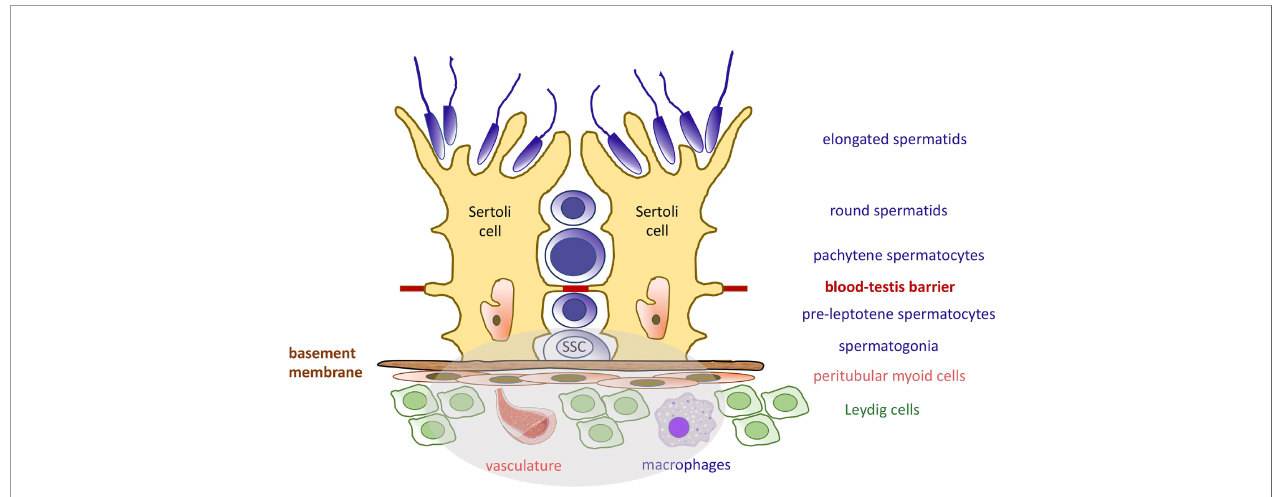
FIGURE 1 | Seminiferous Epithelium Organization and the Spermatogonial Stem Cell Niche. The seminiferous epithelium consists of germ cells (blue) and the somatic Sertoli cells (yellow). Sertoli cells produce many factors needed at various developmental steps during the spermatogenic process. The blood-testis barrier separates diploid germ cells from more mature cells and provide an immuno-privileged microenvironment for the completion of meiosis. Like Sertoli cells, the spermatogonial stem cells (SSCs) are attached to the basement membrane. They rely on speci fi c growth factors for self-renewal and maintenance of the pool. These molecules are produced by Sertoli cells, peritubular myoid cells, Leydig cells, and macrophages, as well as the vasculature. The components of the SSC niche are highlighted in the grey